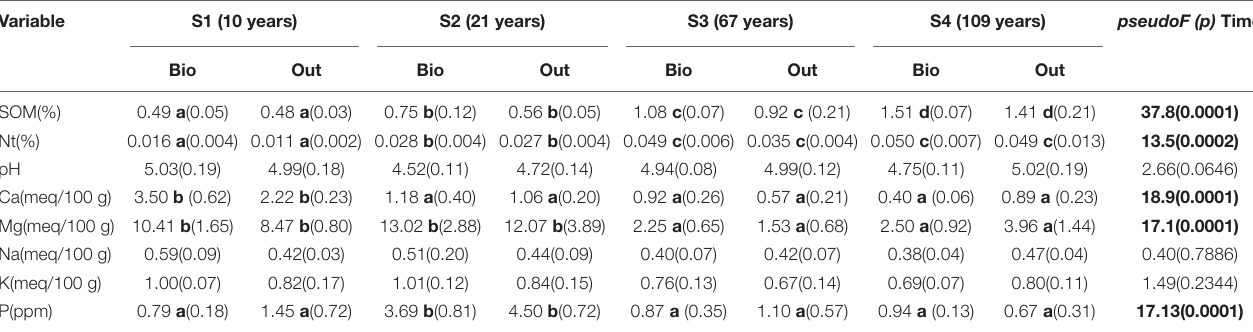
TABLE 1 | Average (standard error) for soil properties (0–3 cm) studied within biocrusts (Bio) and in paired areas outside (Out) in four sites (S1 to S4) along a glacier chronosequence (years since glacier retreat) in the forefront of the Humboldt glacier, Venezuela. Variable Bio Out Bio Out Bio Out Bio Out